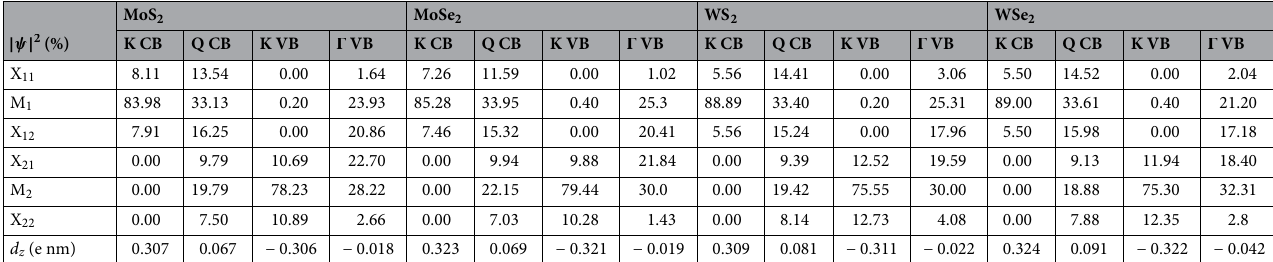
Table 3. Wavefunction projections onto atomic layers for XM ′ stacked TMD bilayers, for atomic positions shown in Fig. 1, together with the dipole moment d z = e � ψ | z | ψ � , for valence (VB) and conduction (CB) states at important points in the Brillouin zone ( Q = K / 2 ).